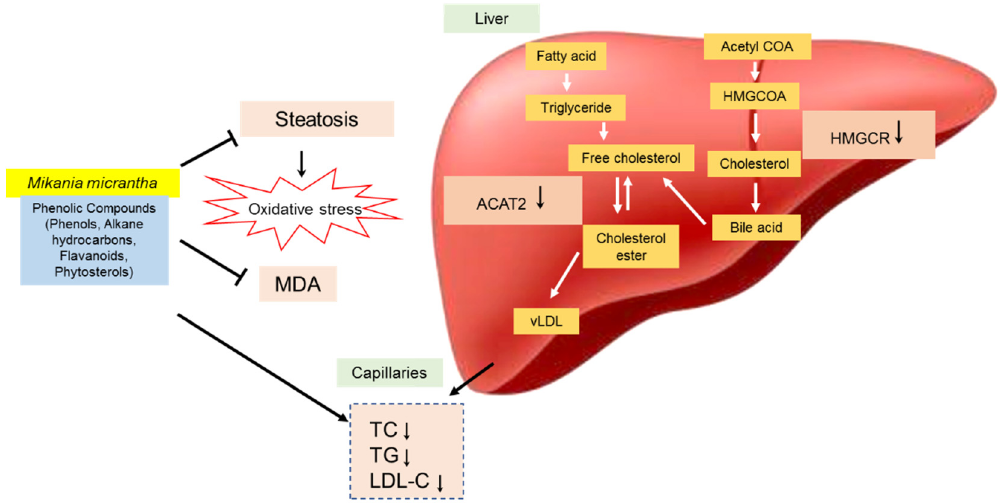
Figure 4. Proposed molecular mechanisms involved in hypocholesterolemic effects of Mikania micrantha stem extract (EAMMS) via inhibition of hepatic lipid accumulation, lipid peroxidation, HMG-CoA reductase (HMGCR) and ACAT2; leading to a decrease of cholesterol concentration.